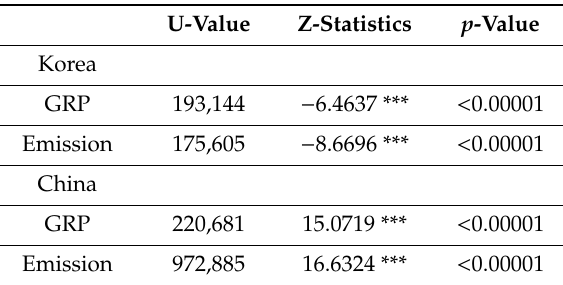
Table A4. Results of Mann-Whitney U-test.